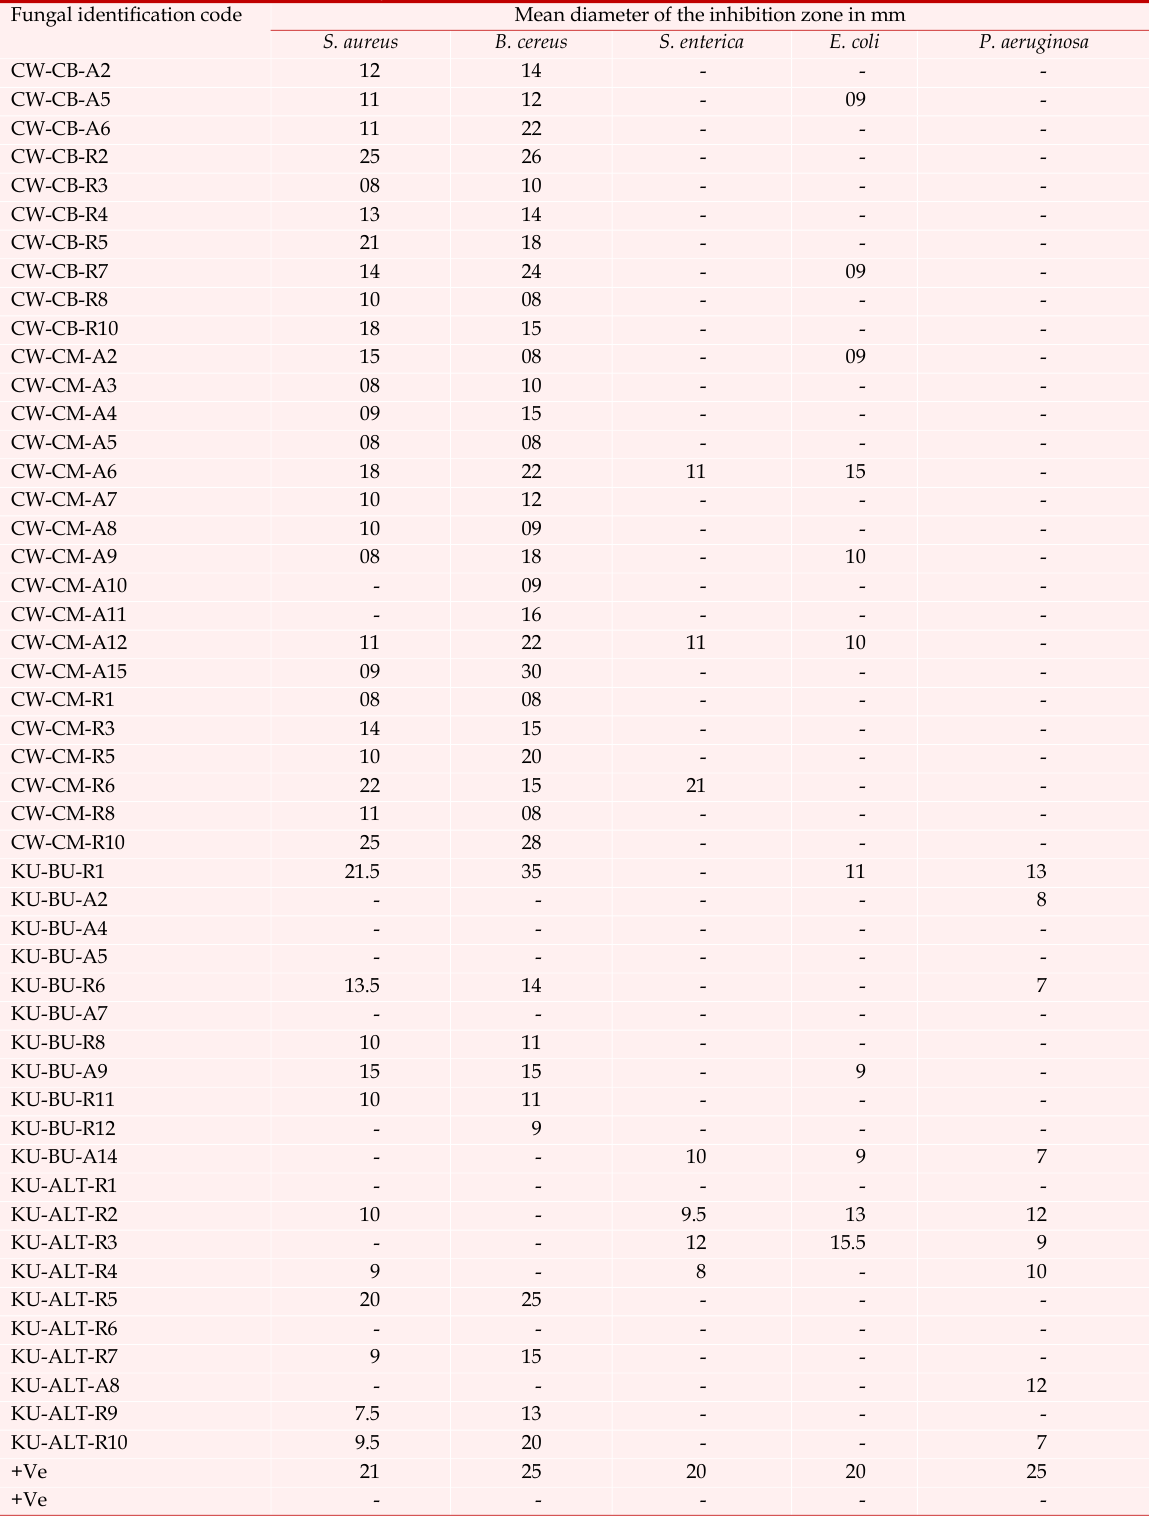
Antibacterial activities of the crudes extracts of endoph ytic fungi from C. brevifolius , C. melanosperrmus, C. alternifolius, C. bulbosus at 4 00 µg/disc concentration Fungal identification